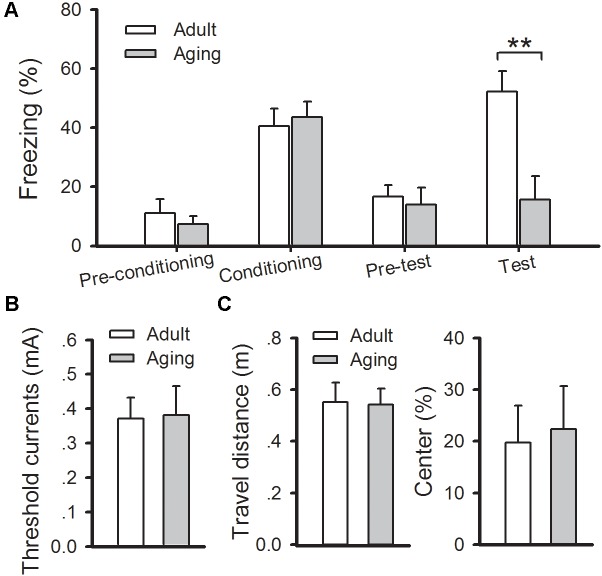
Aged rats exhibit a deficit in cued fear memory. (A) During fear training, there was no observable difference in freezing rates between healthy adult and aged rats, while freezing responses were significantly decreased in aged rats during cued memory test (∗∗p < 0.01). (B) There was no significant difference in the pain threshold between the two groups. (C) There was no significant difference in either locomotion (left) or anxiety (right) between the two groups. N = 7 rats per group. All data are expressed as the mean ± SEM.